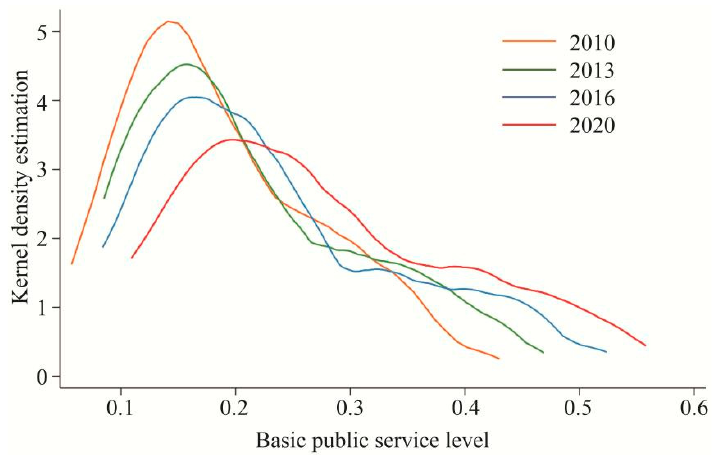
Figure 4. Kernel density estimation curve of the BPSL in the YRDR, 2010–2020.